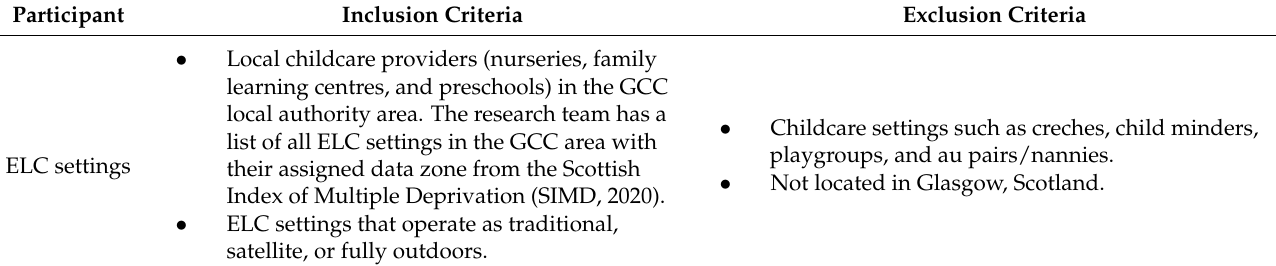
Table 2. Inclusion and exclusion criteria for the feasibility study of nature-based